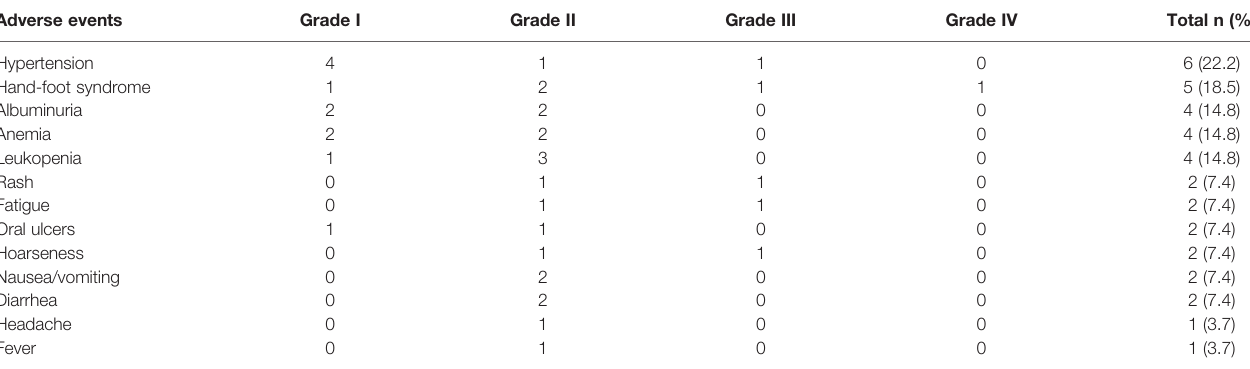
TABLE 4 | Adverse events analysis of the 27 DMPM patients treated with apatinib. Adverse events Grade I Grade II Grade III Grade IV Total n (%) Hypertension